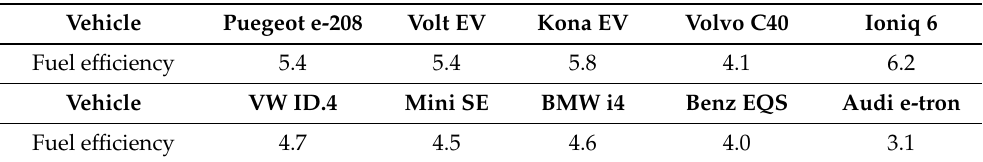
Table 6. Combined fuel efficiency (km/kWh) of other vehicles (Government-approved compound fuel efficiency, South Korea, August